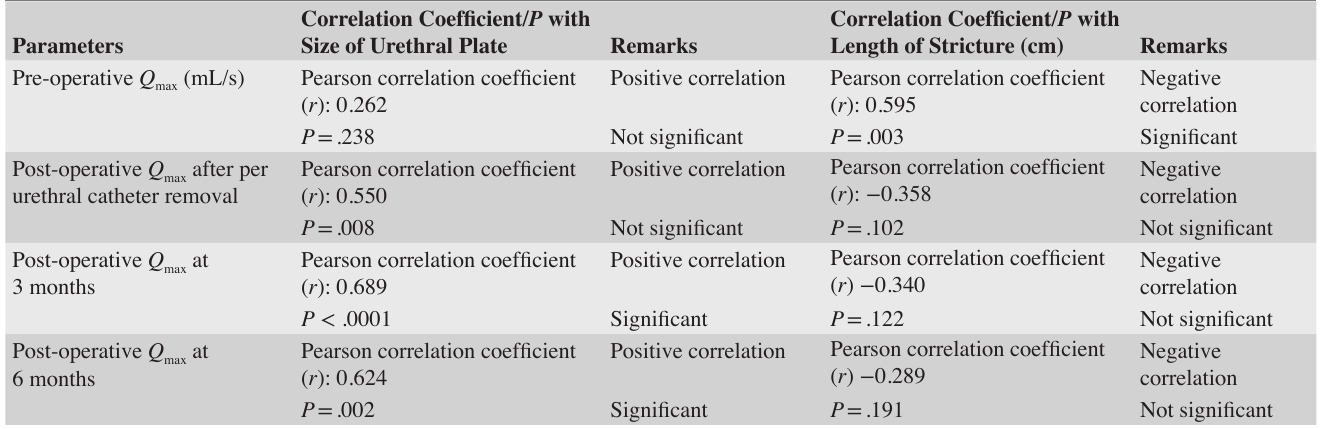
Table 3. Correlation of Size of Urethral Plate and Length of Stricture with Q